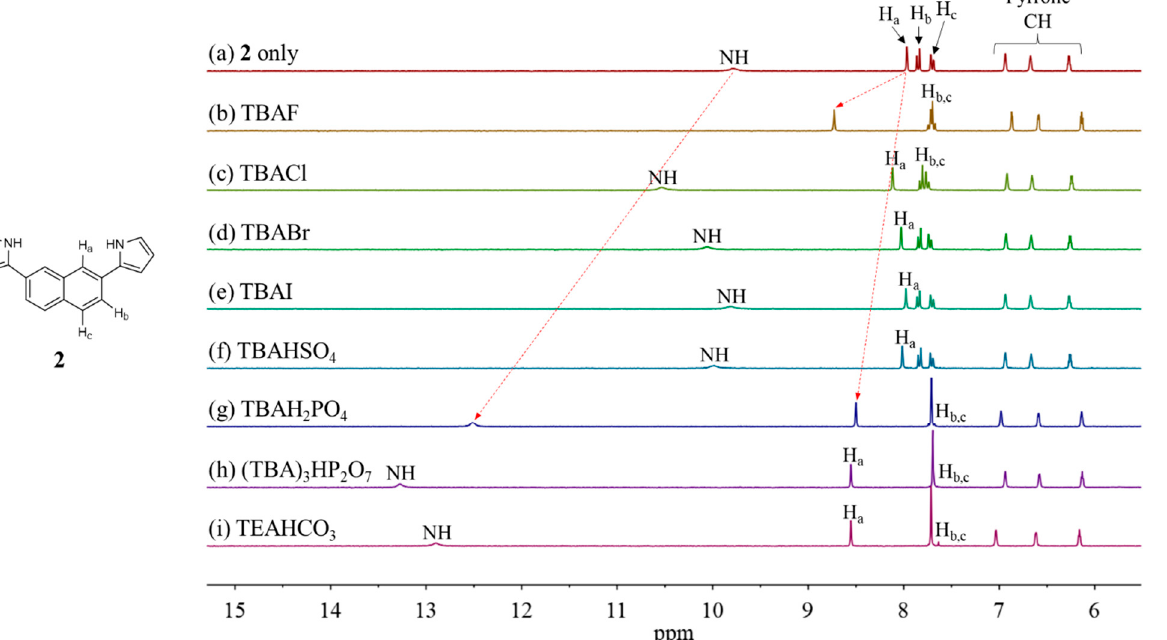
Figure 5. Partial 1 H NMR spectra of (a) 2 (3 mM) only, (b) 2 + excess TBAF, (c) 2 + excess TBACl, (d) 2 + excess TBABr, (e) 2 + excess TBAI, (f) 2 + excess TBAHSO 4 , (g) 2 + excess TBAH 2 PO 4 , (h) 2 + excess (TBA) 3 HP 2 O 7 , and (i) 2 + excess TEAHCO 3 in CD 3 CN.